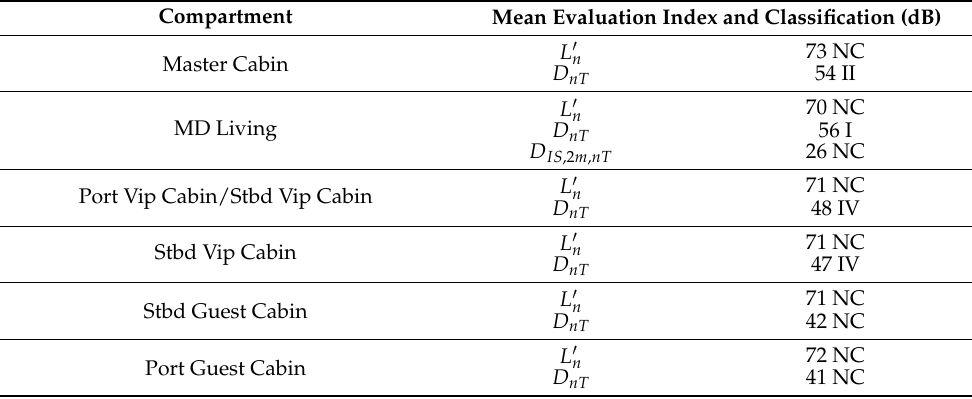
Table 7. Acoustic classification of the ship’s